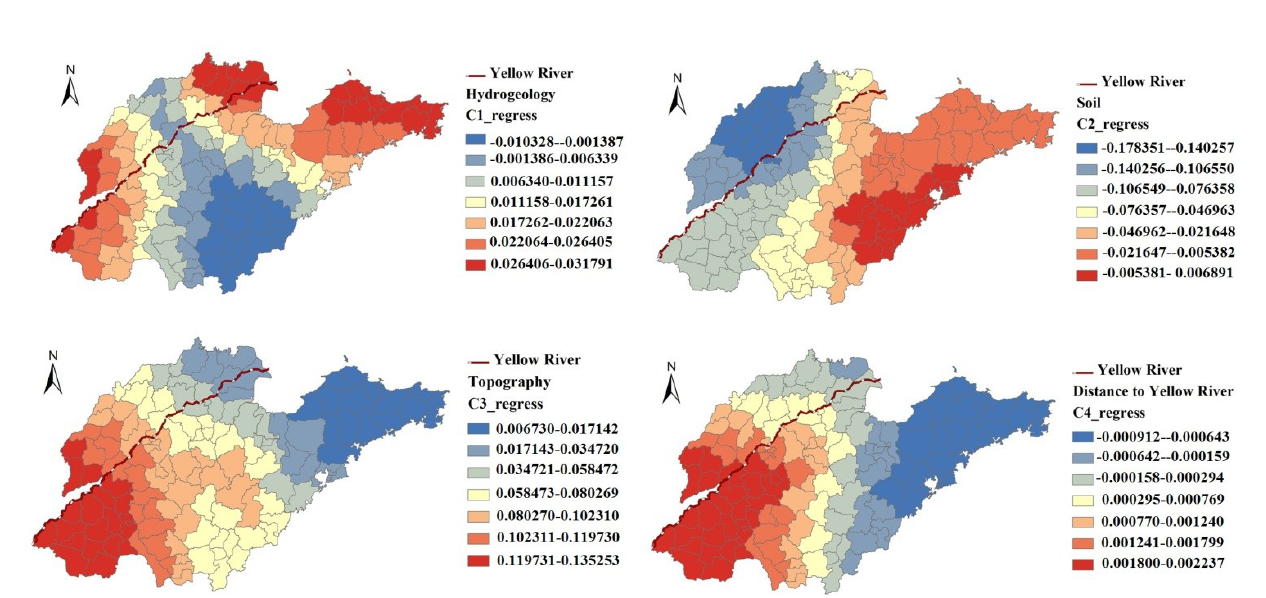
Figure 5. The coefficients of risk factors in Geographically Weighted